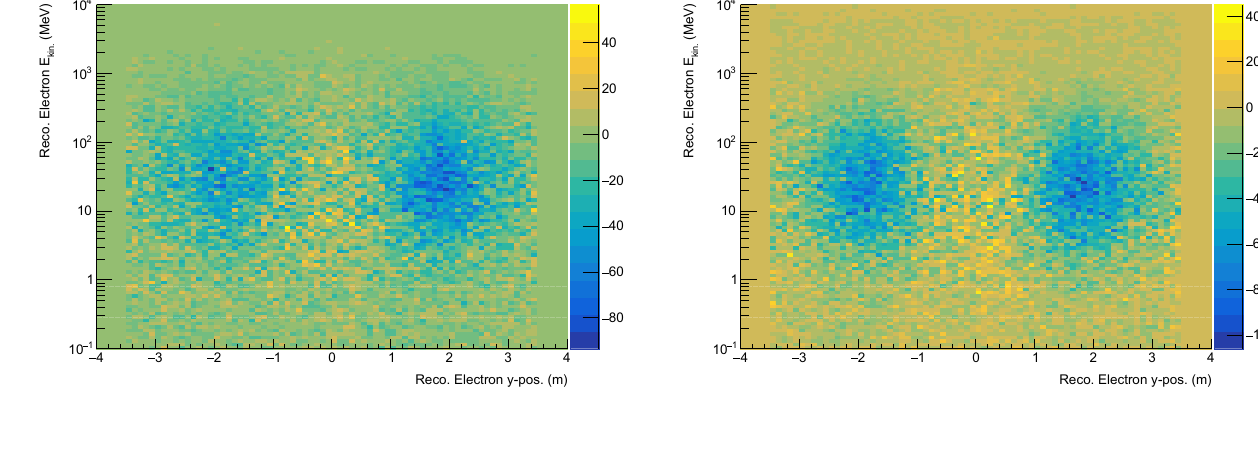
Figure 8. The distribution of the kinetic energy E kin . as a function of the y -position of the reconstructed photons ( left column ) and neutrons ( right column ) in the lower detector plane. The materials analyzed are Magnesium and Cesium ( upper row ), Chromium and Ytterbium ( middle row ), as well as Molybdenum and Lead ( bottom row ). The hits from the empty container are subtracted.